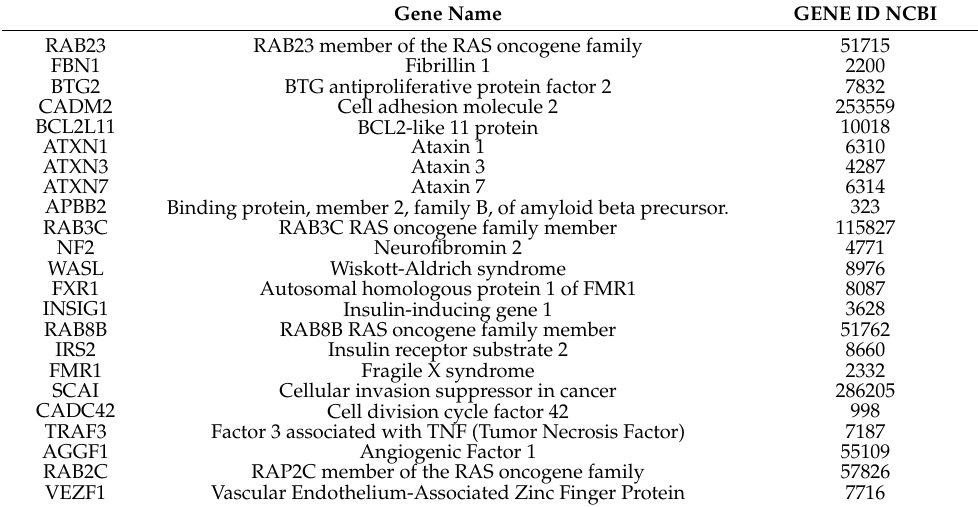
Table 9. Targets of miR-25-3p.